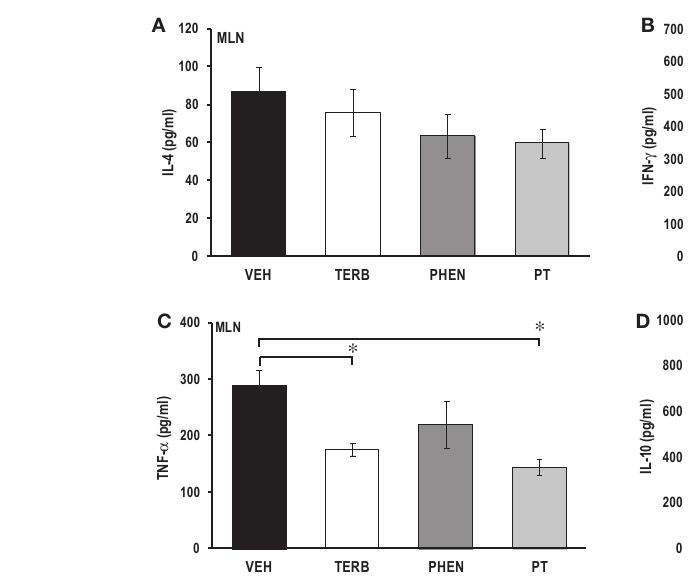
FIGURE 9 | Cytokine production by mesenteric lymph node (MLN) cells after 24h of culture . Animals were treated with twice-daily i.p. injections of vehicle (VEH, black bars), terbutaline (TERB, white bars), phentolamine (PHEN, dark gray bars), or phentolamine and terbutaline (PT, light gray bars) initiated 12days after adjuvant challenge. (A) IL-4 production was comparable